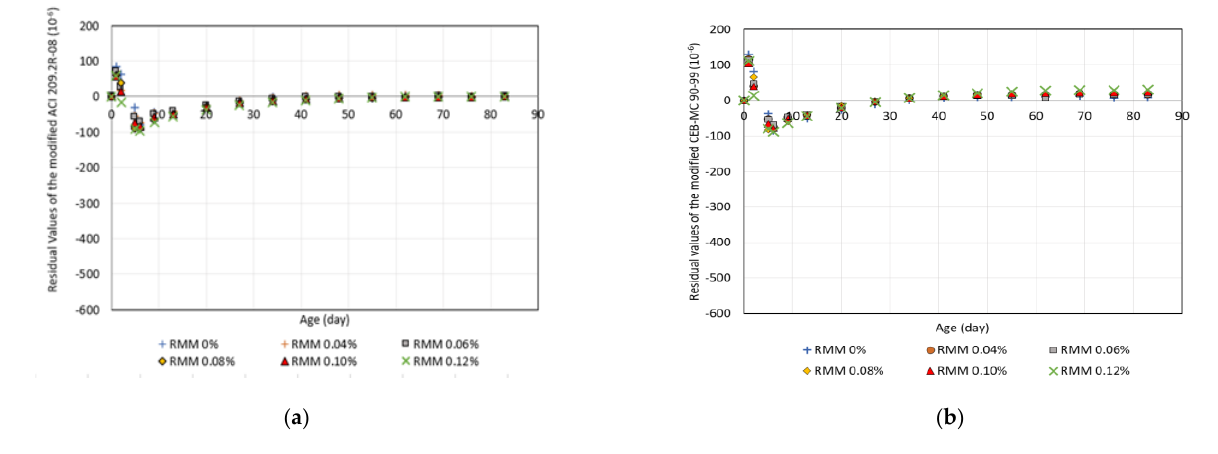
Figure 10. Evaluation of the modified ACI 209.2R-08 ( a ) and the modified CEB-MC 90-99 ( b ) models by best fit line method.